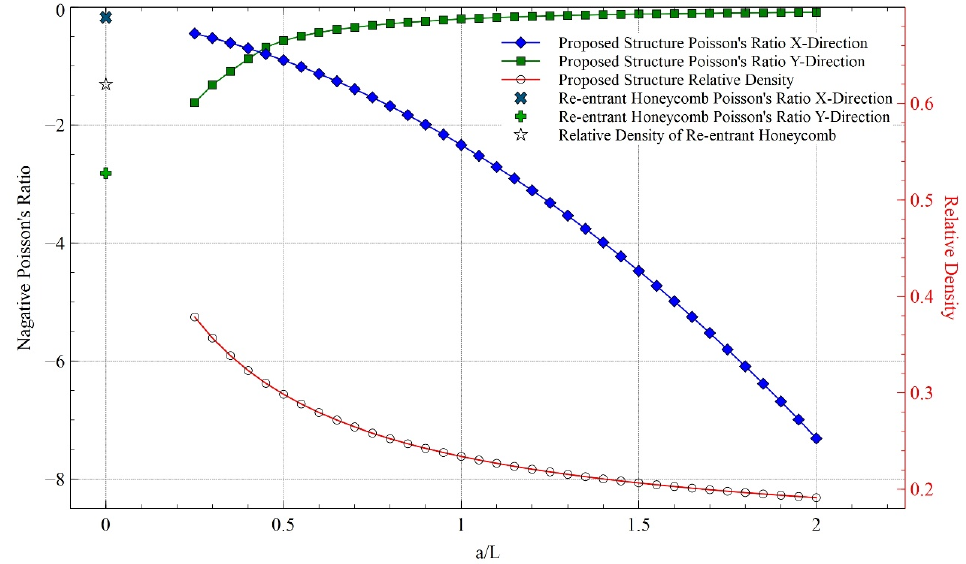
Figure 20. Relative density and NPR for loading in both directions.